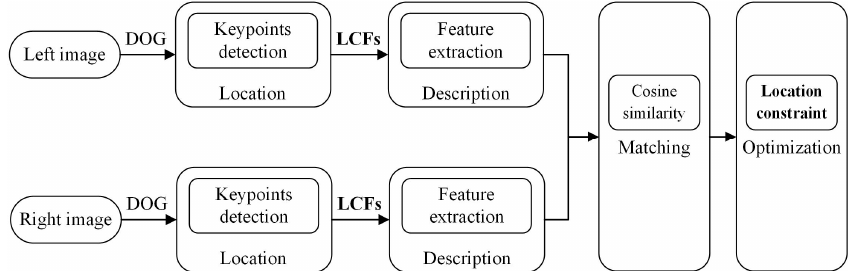
Figure 1. Keypoint matching approach framework. Among them, DOG = difference-of-Gaussian, LCFs = Local Convolutional Features.